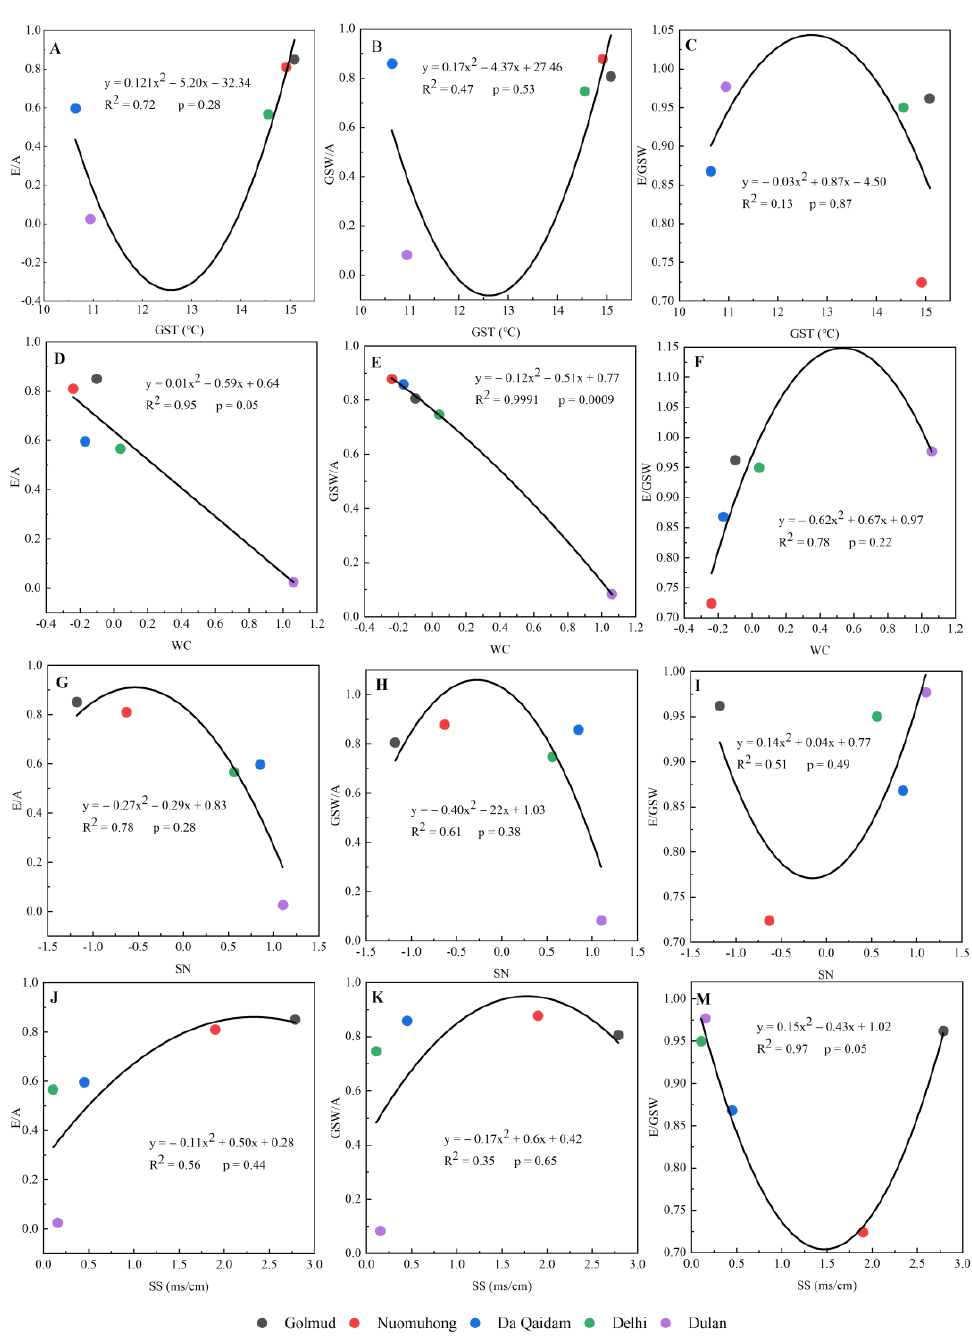
Figure 6. Effect of environmental factors on the relationship among photosynthetic production traits and water use traits of plants.